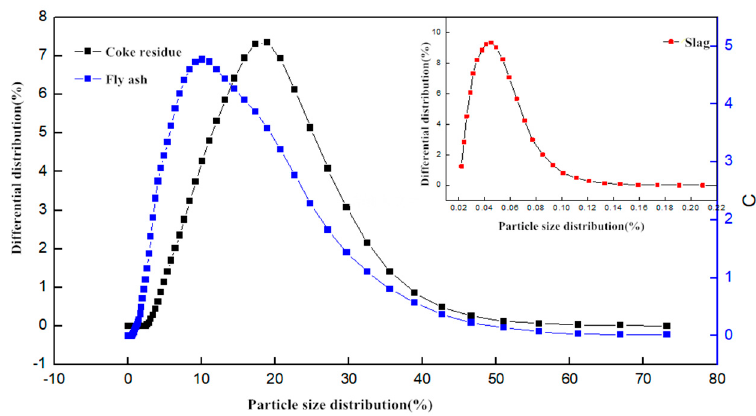
Figure 4. The particle size distribution of different mineral admixtures.